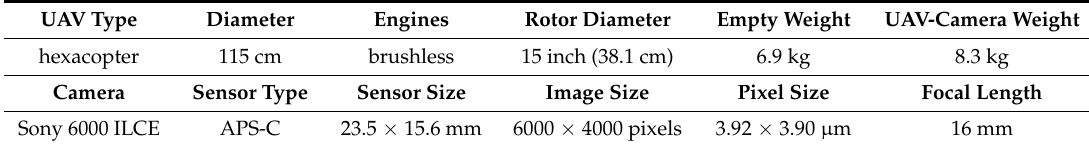
Table 1. UAV and UAV-camera specifications.